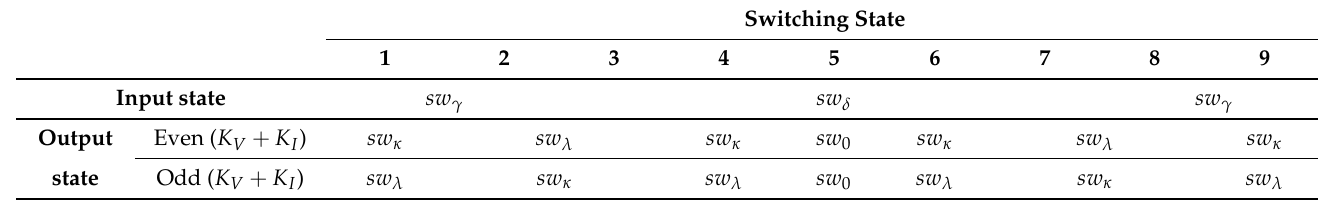
Table 7. Switching pattern of the CSVM for the switching period T s .